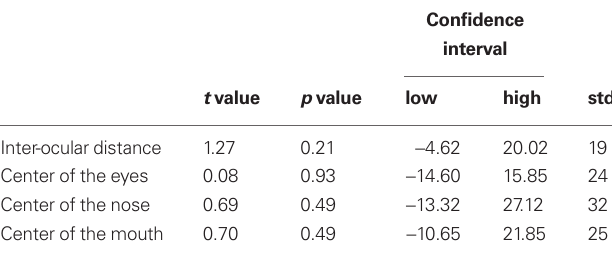
Table 1 | results of analyses of differences in facial feature positions (measured in pixels) between familiar and unfamiliar face stimuli (df = 38).